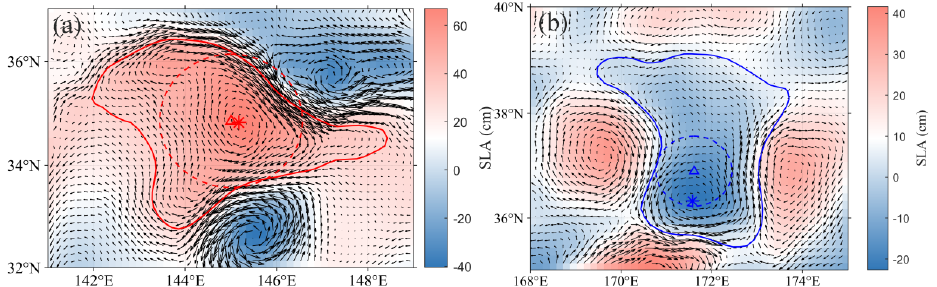
In addition, the eddy amplitude difference is similar to the eddy radius difference. Figure 22. Comparison of eddies’ boundaries on ( a ) 1 January 2019 and ( b ) 7 March 2019 in the KE